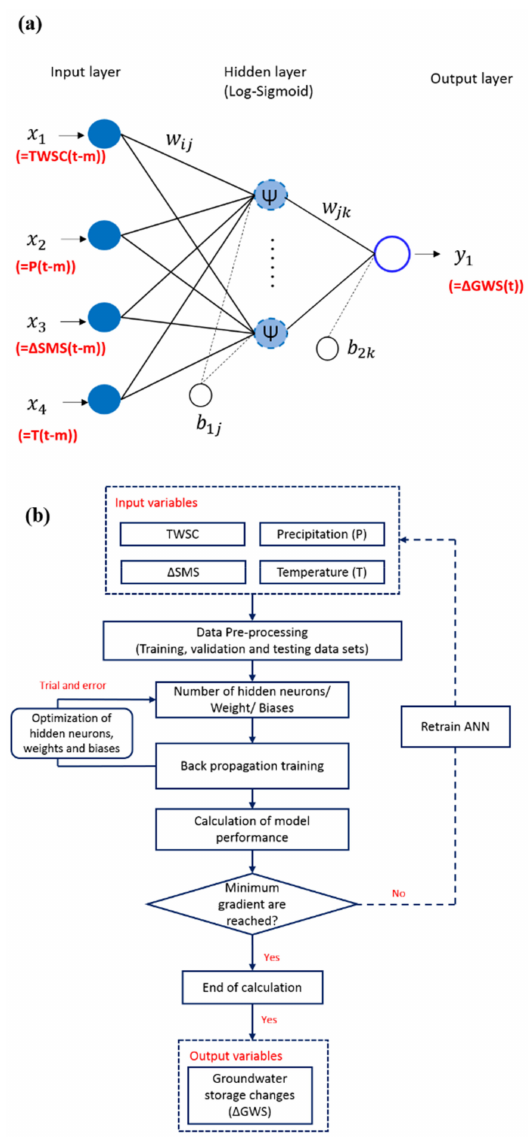
Figure 3. ( a ) Structure of the artificial neural network (ANN) model used for groundwater storage changes ( ∆ GWS) predictions; ( b ) ANN model